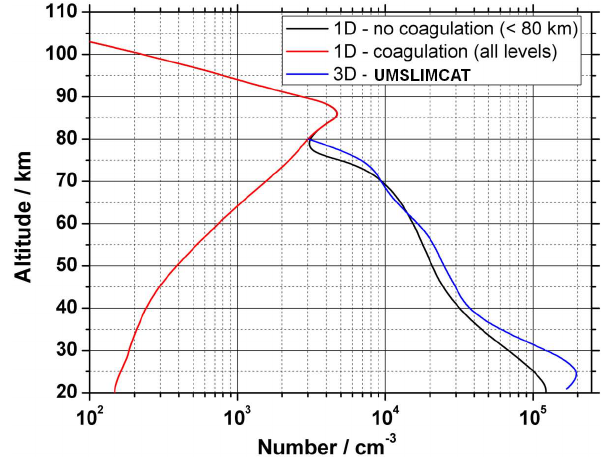
Fig. 4. Vertical profiles of the MSP concentration predicted by the 1D model for the case where there is coagulation below 80km (red line) or coagulation is switched off (black line). The global meteoric mass input rate is 22td − 1 . The blue line shows the MSP density profile calculated by UMSLIMCAT for June at 65 ◦